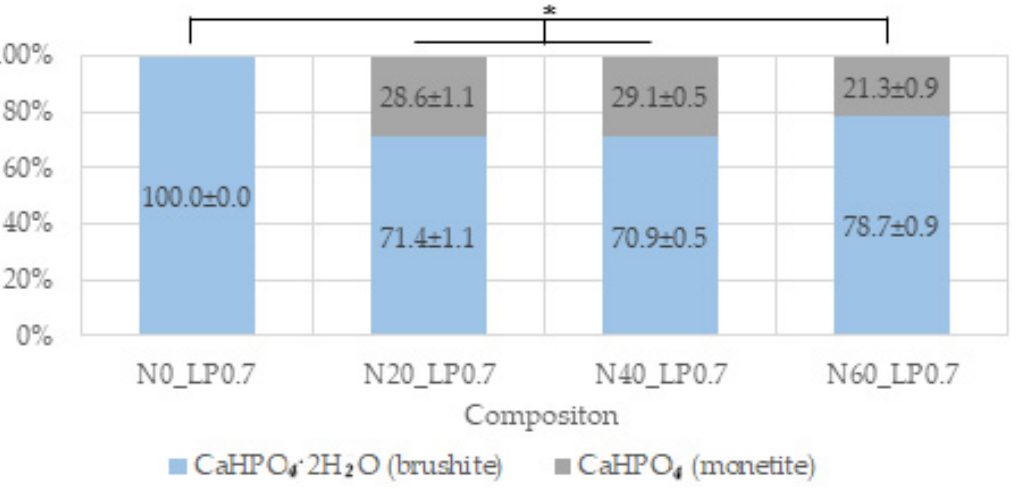
Figure 12. Quantitative phase composition of ceramics after implantation. Significant differences are labeled with * ( p < 0.05).